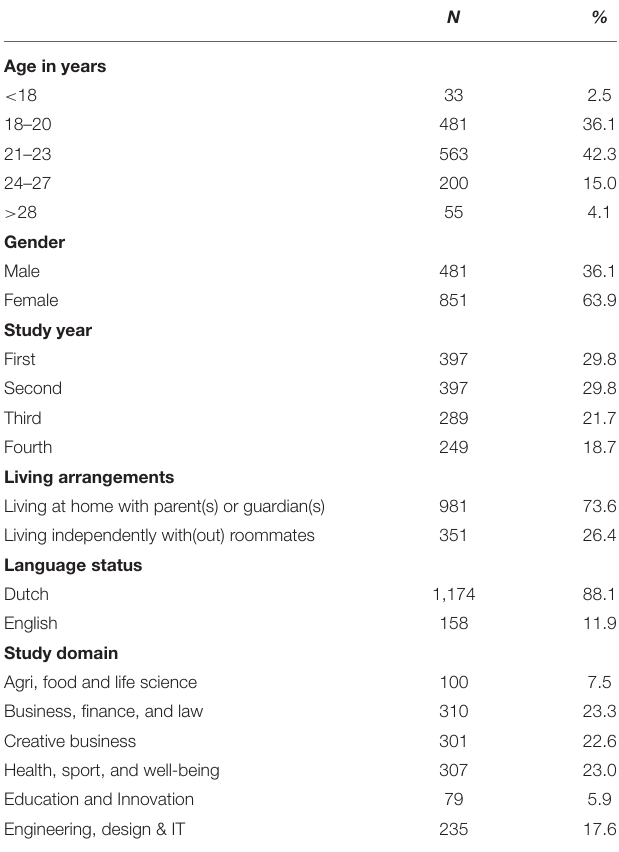
TABLE 2 | Sociodemographic characteristics of participants ( N =